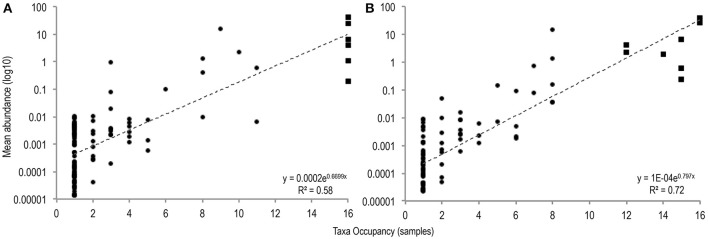
The number of samples in which taxa were observed plotted against mean taxa abundance (log10 scale) in untreated sample (A), and PMA-treated sample (B), conditions [(A: r2 = 0.58; P = <0.001), (B: r2 = 0.72; P = < 0.001)]. Common taxa (>75% sample occupancy) are plotted square, rare samples (<75% sample occupancy) are plotted circle.